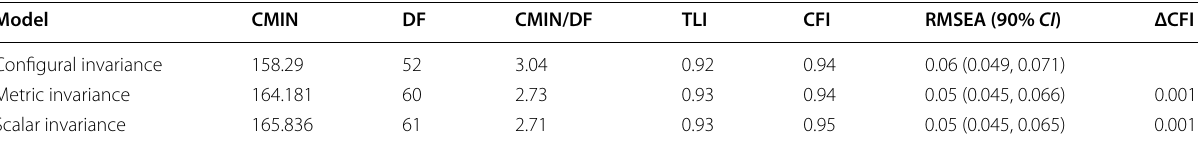
Table 5 Measurement invariance of the Positive Mental Health (PMH) scale across genders Model